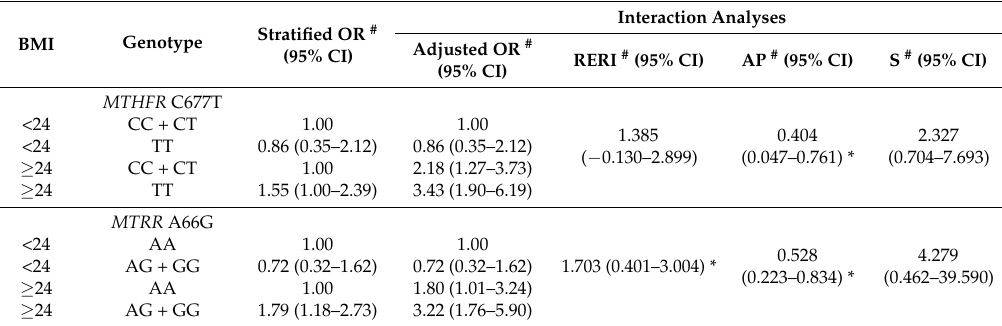
Table 3. Interaction of being overweight/obesity with the MTHFR C677T and MTRR A66G polymorphisms on type 2